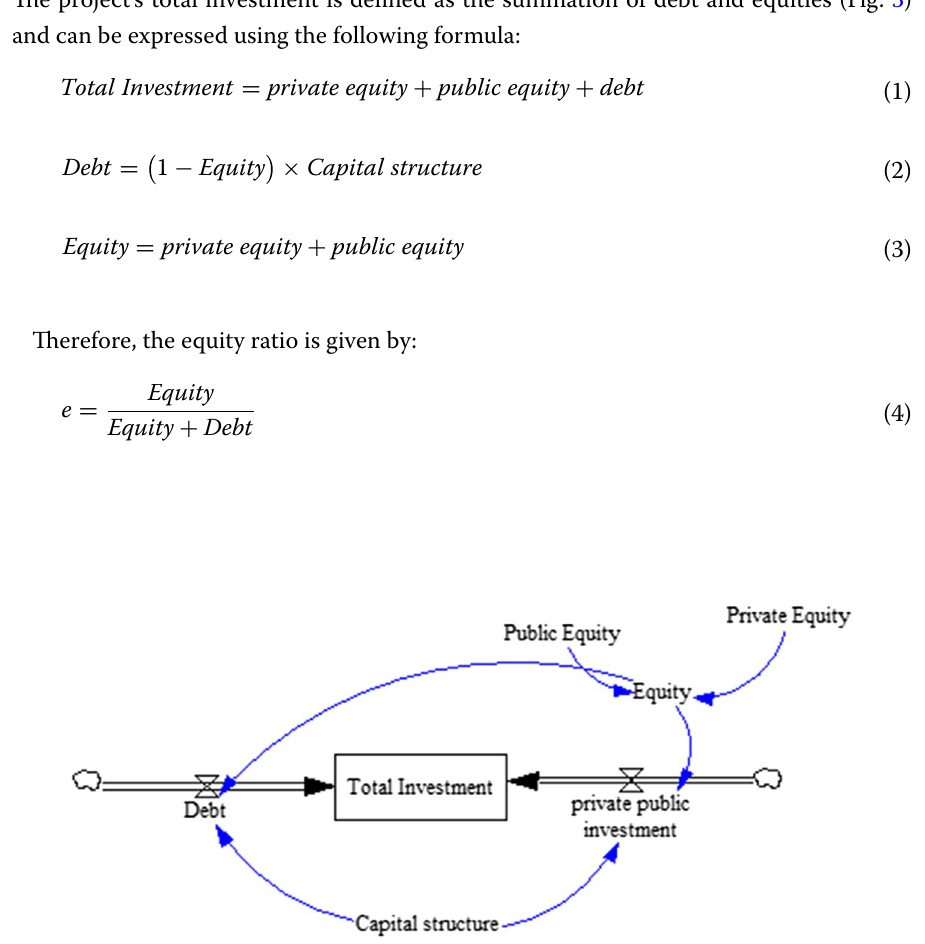
Fig. 3 Stock and flow diagram for total